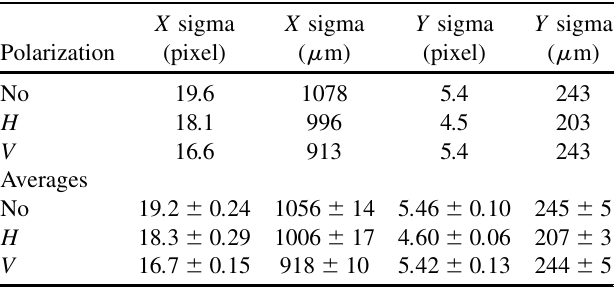
TABLE IV. Summary of 7-GeV APS OTR data with 3.2 nC. The horizontal ( H ) polarization data are indicated in determining the y sizes and vice versa with the vertical ( V ) polarization data. The first three data rows are based on ten-image sums, and then the ten images were processed individually to determine the averages and the statistical errors.